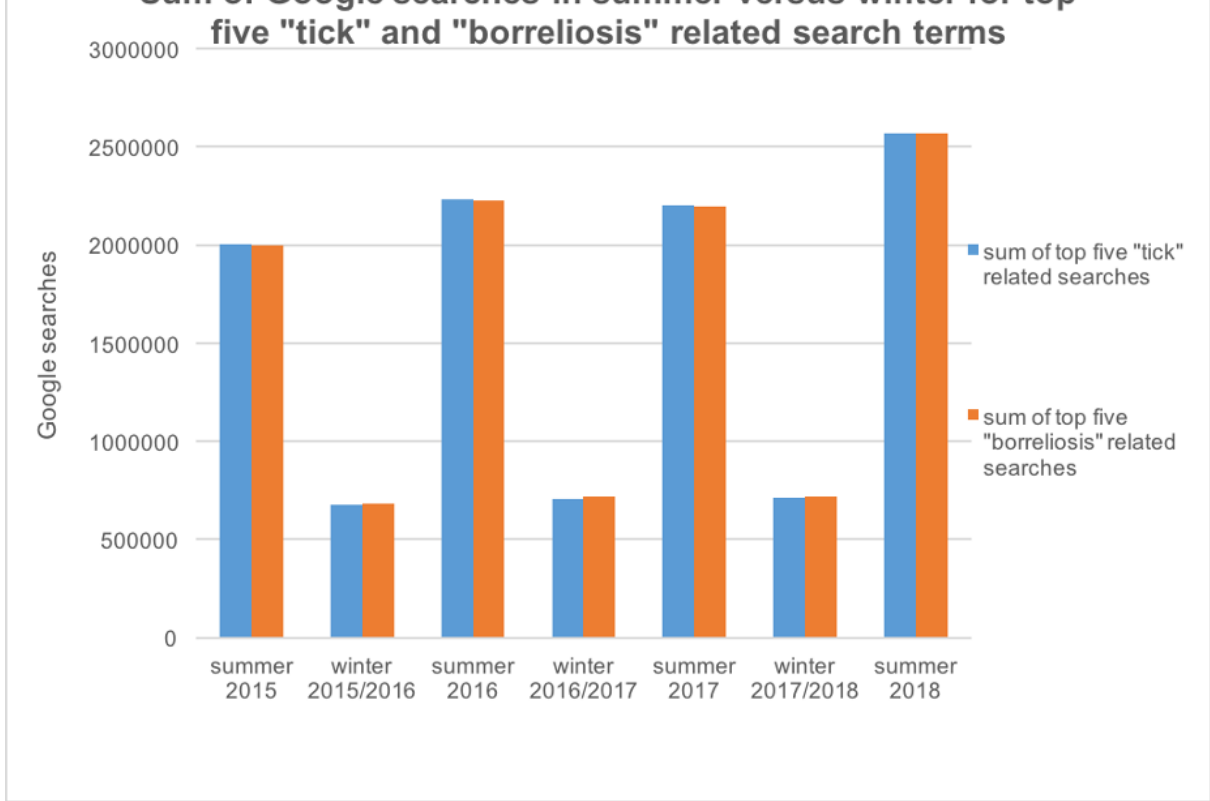
Figure 1. Google searches in Germany in summer (April to September) vs winter months (October to March) for the top five tick- and borreliosis-related search terms in